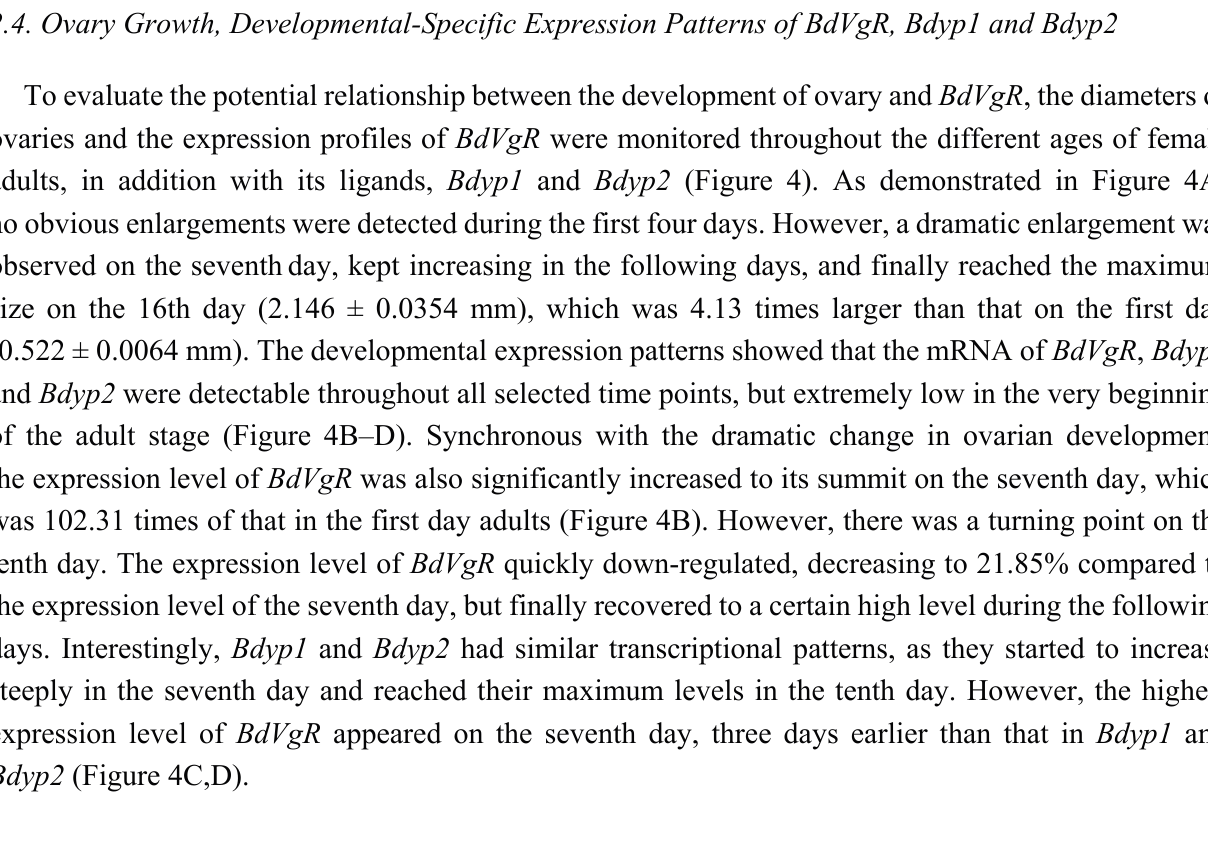
Figure 3. Spatial-expression patterns of BdVgR in different body segments and tissues of seven-day-old female adults. The tissues and segment included the fat body (Fb), midgut (Mg), Malpighian tubule (Mt), head (Hd), thorax (Th), ovary (Ov). And α -tubulin ( α -tub ) was used as a reference gene. The thermal cycles for PCR amplification was 30 times, yielding 163 and 184 bp PCR products for BdVgR and α -tubulin ,